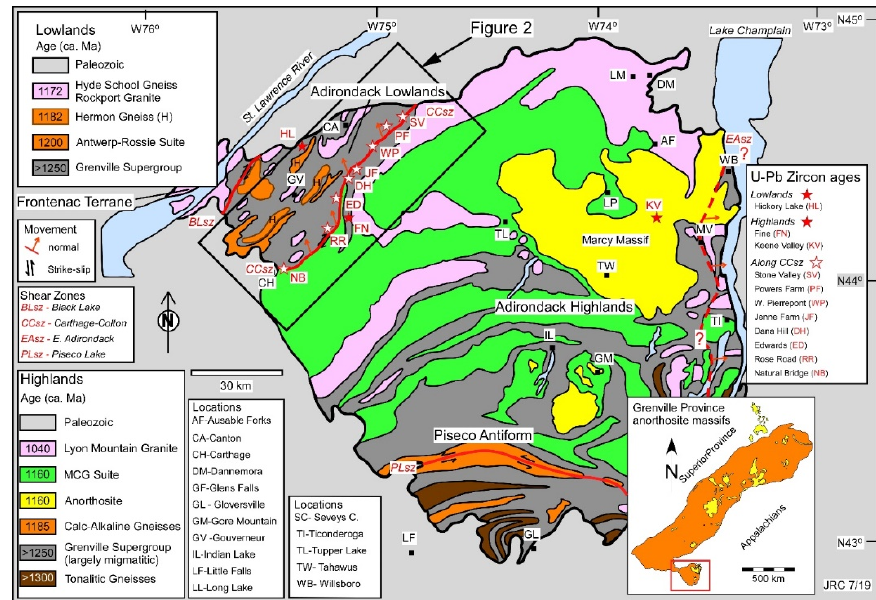
Figure 1 . Simplified geologic map of the Adirondack Region. Inset shows the location of major anorthosite bodies in yellow within the contiguous Grenville Province (in orange) and the area covered by the figure (red rectangle). The black, diagonally oriented rectangle is shown in additional detail in Figure 2. Stars represent sampling sites described in the text. Figure modified from Chiarenzelli et al. [14].